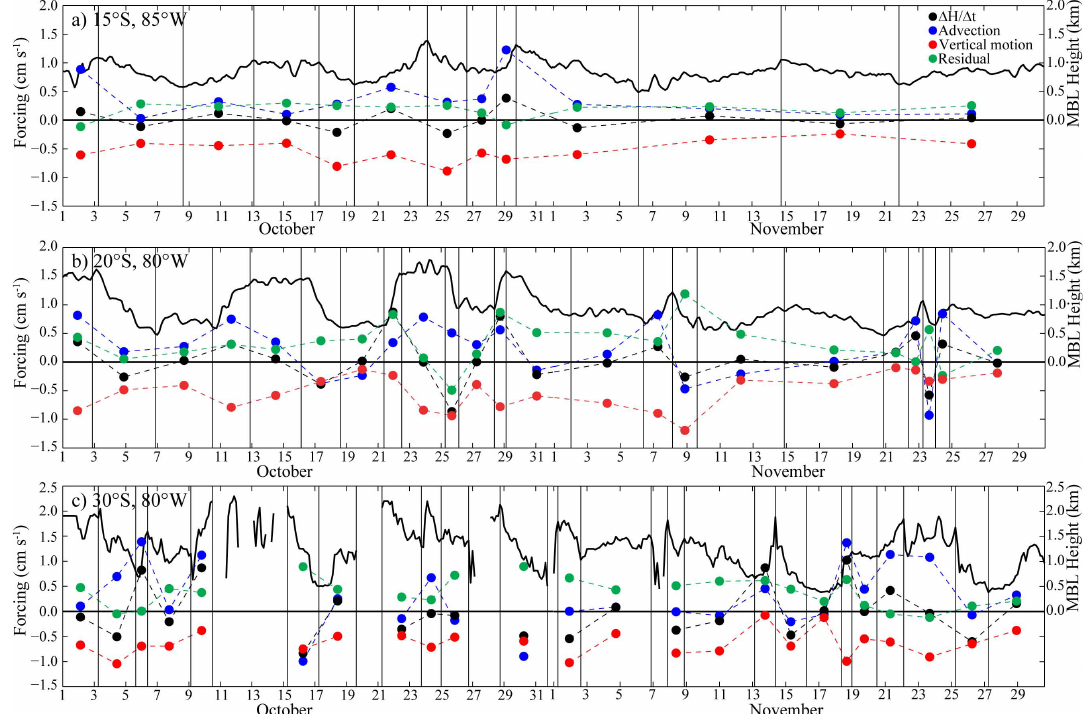
Fig. 8. Time series of WRF-simulated MBL height (m, solid contour), and averages of three-hour change of height (cms − 1 , black), advection (cms − 1 , blue), vertical motion at MBL top (cms − 1 , red), and residual (cms − 1 , green). Time range of averages indicated by vertical lines. Locations are at (a) 15 ◦ S, 85 ◦ W, (b) 20 ◦ S, 80 ◦ W, and (c) 30 ◦ S, 80 ◦